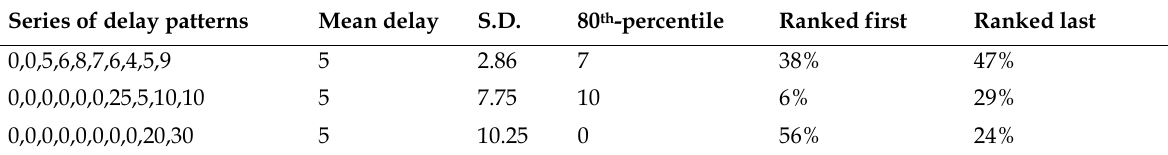
Table 2. Results of Benwell & Black (1984) (modified: 80 th -percentile added) Series of delay patterns Mean delay S.D. 80 th -percentile Ranked first Ranked